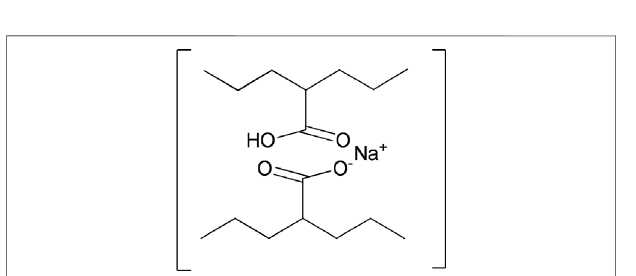
FIGURE 7 | Molecular structure of Depakote ®